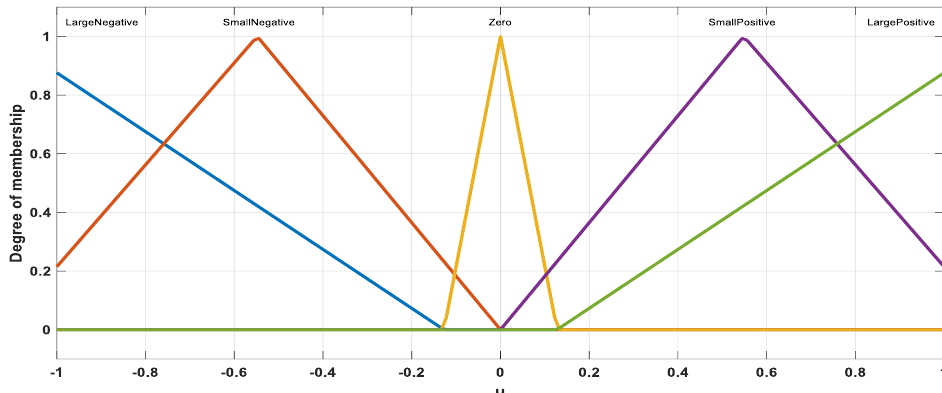
Figure 8. Optimal output control signal triangular membership functions.